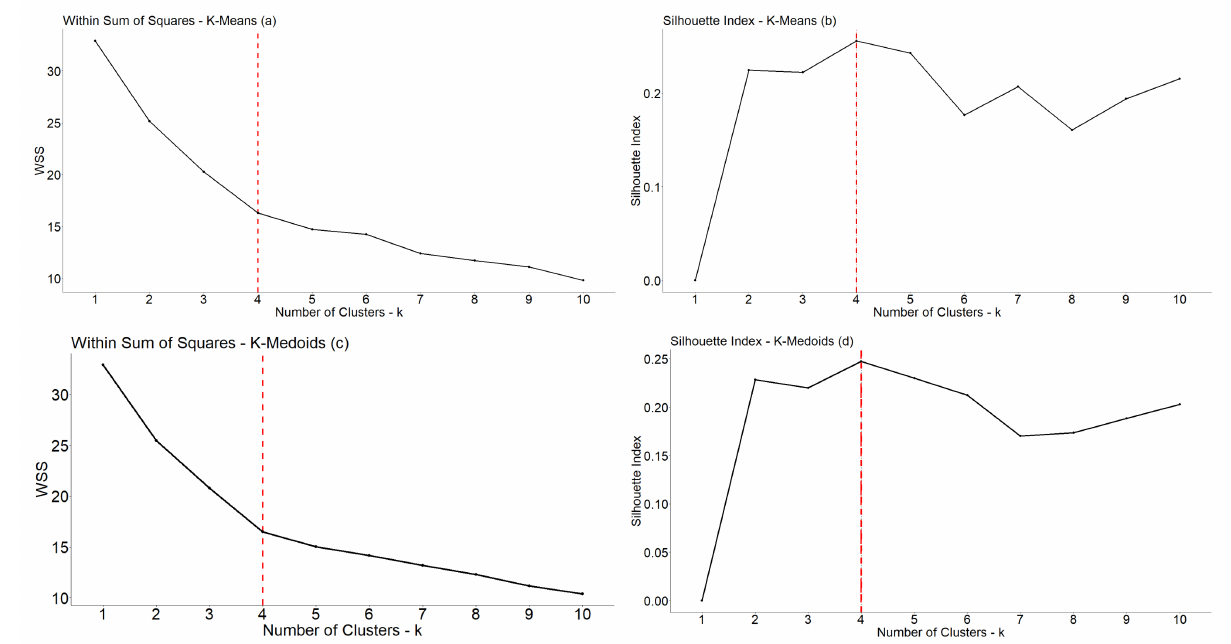
Figure 13. WSS and silhouette index for k-means and k-medoids